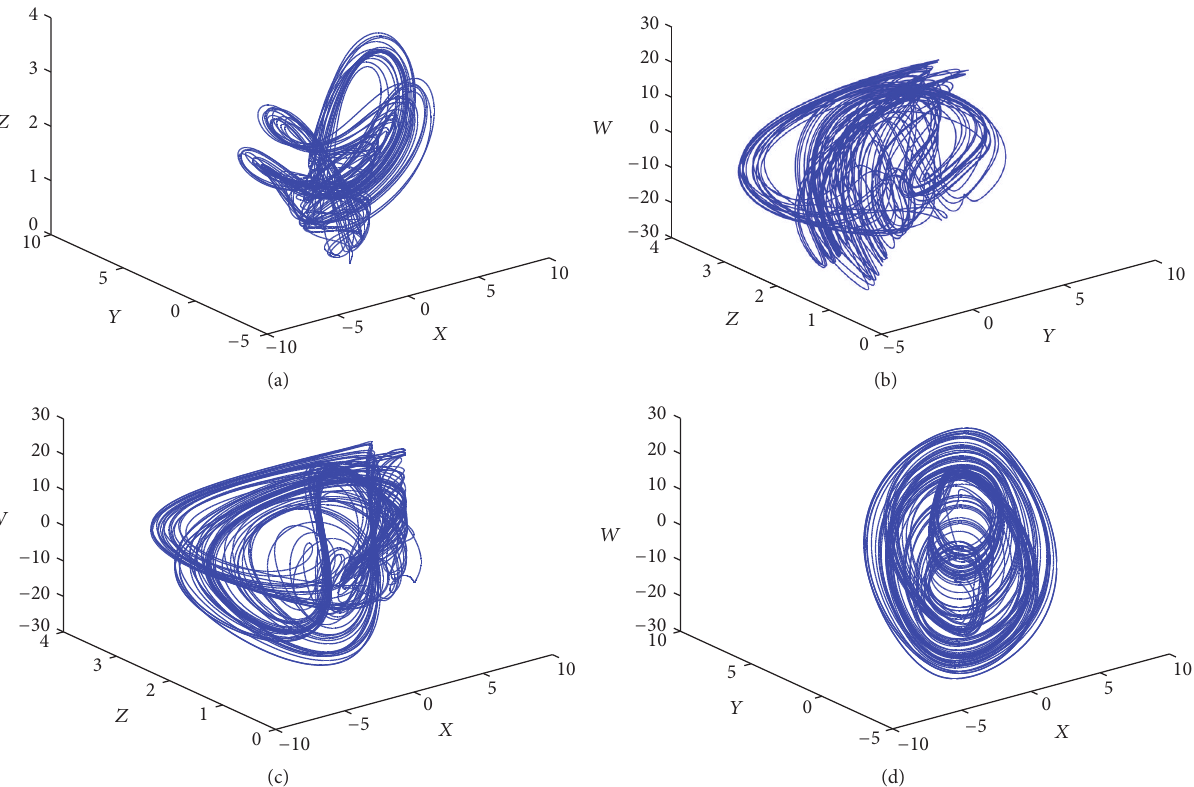
Figure 21: Tridimensional projections of the highly complex chaotic attractor coexisting with the hyperchaotic one. Initial conditions: (0.1, 0.1, 0.1, 0.1) .